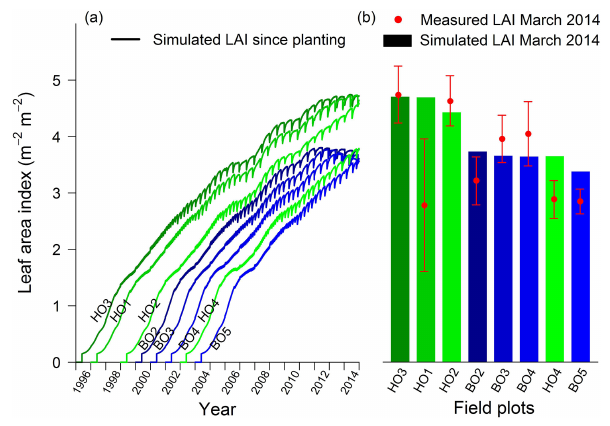
Figure 10. Validation of yield and NPP with eight independent oil palm sites from the Harapan (H) and Bukit Duabelas (B) regions with different fertilization treatments. Field data were collected in